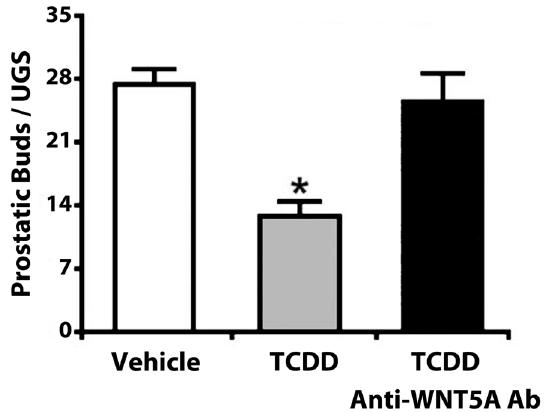
Figure 6. Anti-WNT5A antibody reversed the inhibitory effects of TCDD-induced activation of AHR signaling in vitro . UGSs from male C57BL/6J mouse embryos were harvested at E14.5 and cultured in vitro for three days. While culture with TCDD (1 nM) reduced total prostatic bud number, culture with TCDD (1 nM) plus a neutralizing anti-WNT5A antibody restored prostatic bud number to a level similar to that of control UGSs. An asterisk indicates a significant difference from control UGSs ( p ≤ 0.05). Adapted from